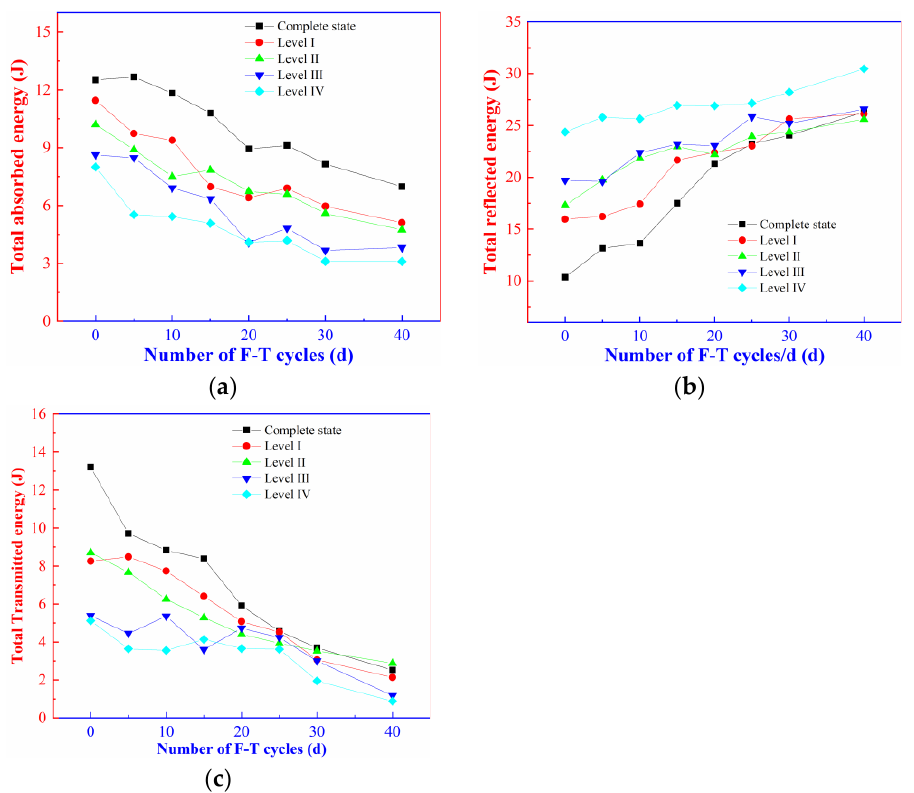
Figure 8. Distribution curves of the number of F-T cycles with energy: ( a ) Total absorbed energy; ( b ) Total reflected energy; ( c ) Total transmitted energy.